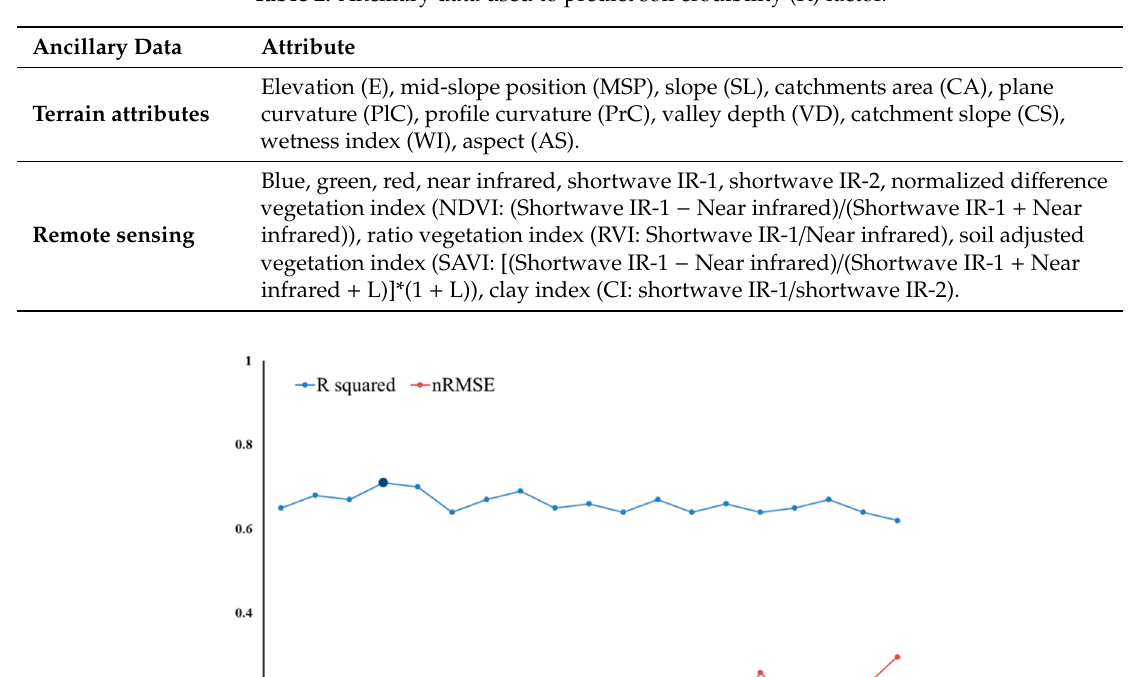
Table 2. Ancillary data used to predict soil erodibility (K) factor.